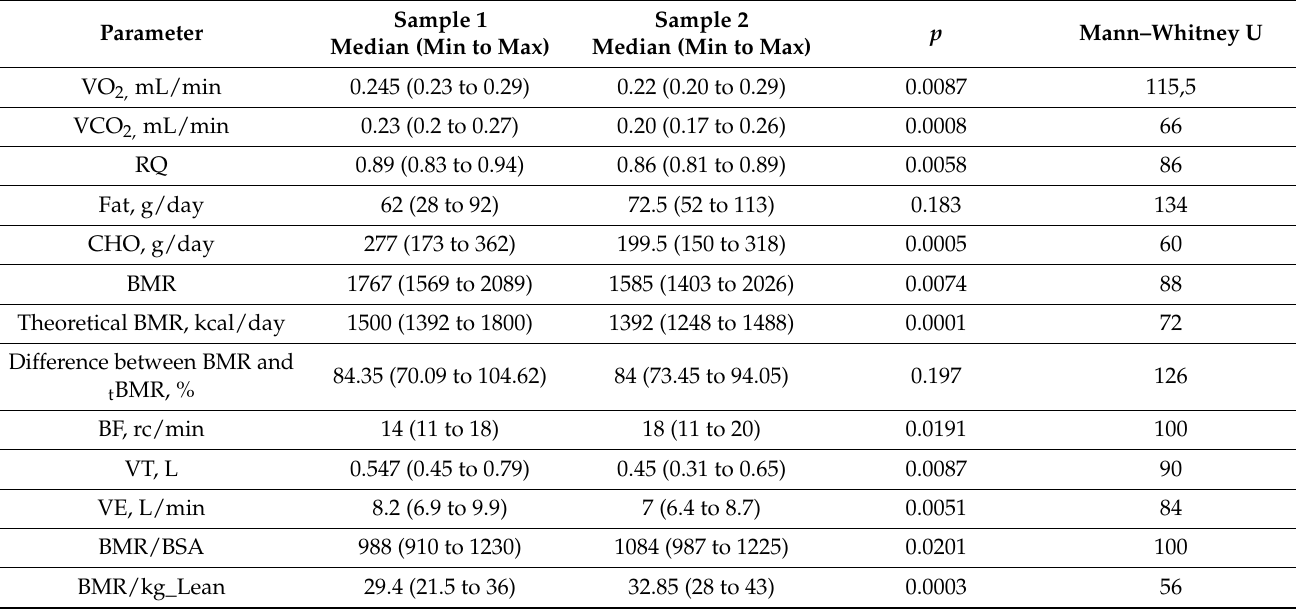
Table 2. A comparative analysis regarding the BMR measurement in Sample 1 and Sample